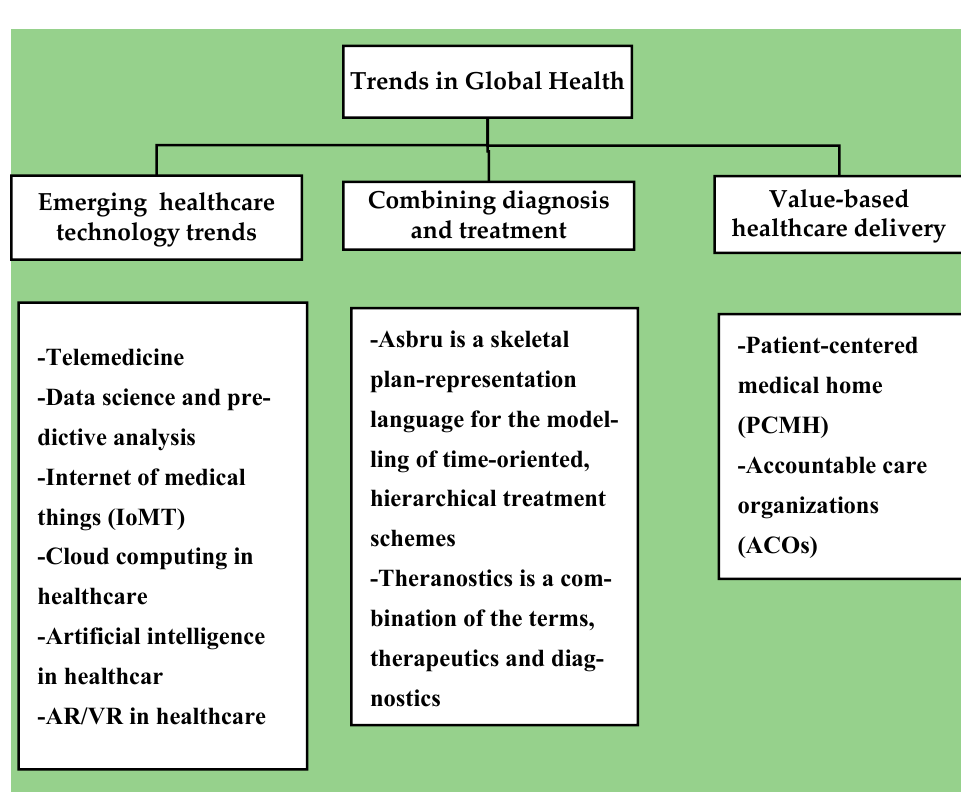
Figure 1. Different Trends in Global health.